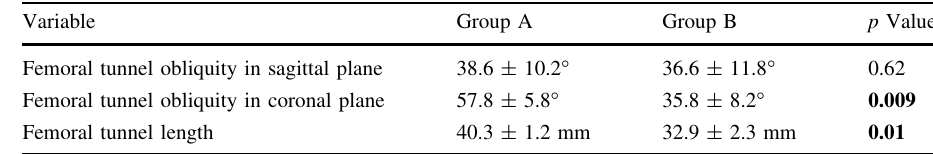
Table 3 Radiological findings at follow-up, comparison between groups